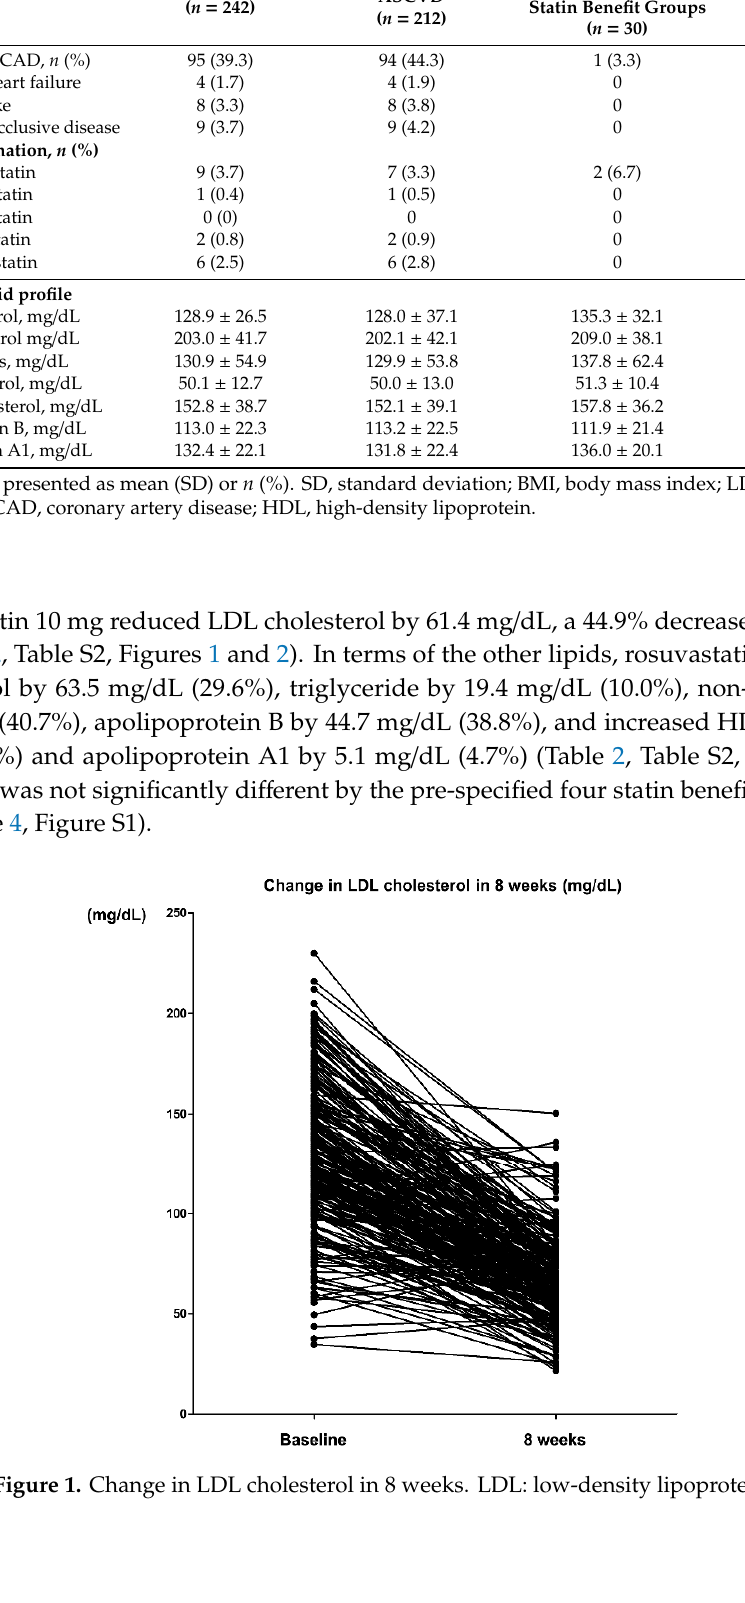
Table 2. Changes in lipid profiles as per ACC/AHA guidelines for the four statin benefit groups, by clinical atherosclerotic cardiovascular disease (ASCVD).